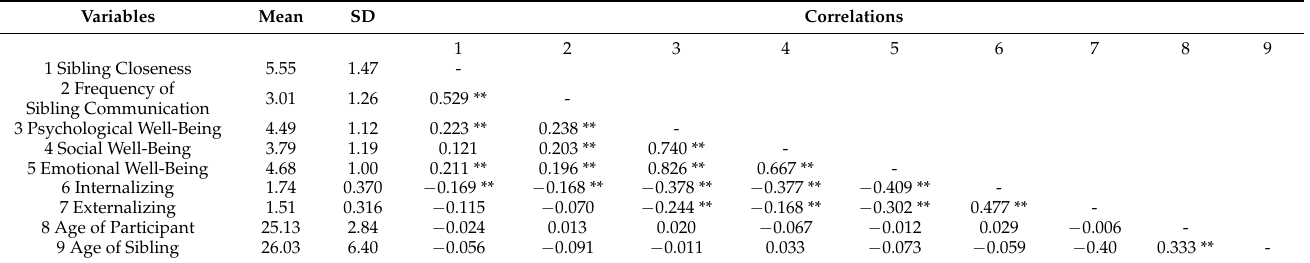
Table 1. Means, Standard Deviations, and Correlations of Model